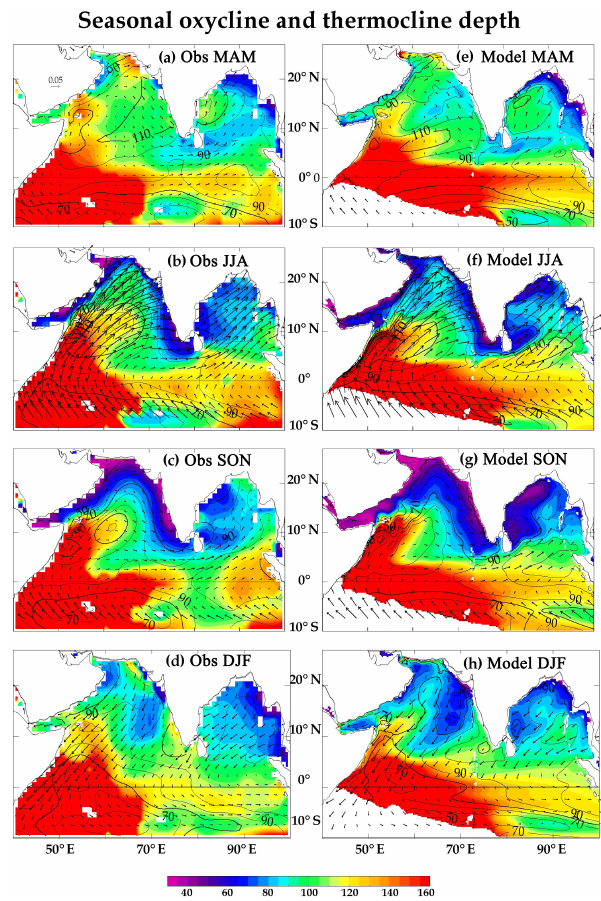
Figure 6. Maps of the seasonal climatology of oxycline (m; shaded) and thermocline depths (m; contours with 10m interval) from WOA13 during (a) March–May, (b) June–August, (c) September– November, and (d) December–February. (e–h) Same as (a–d) but from the model. Seasonal wind stress (Nm − 2 ) patterns from the model forcing field are also shown as vectors in all